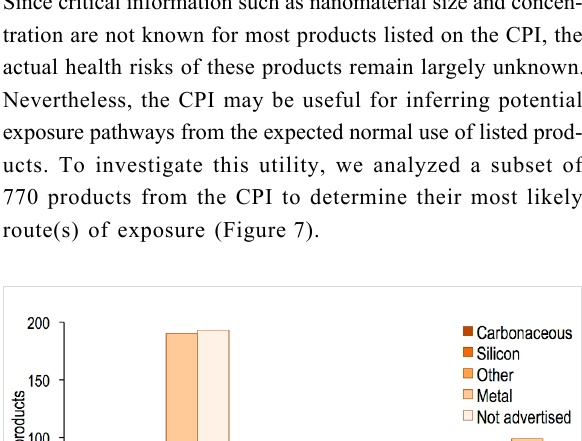
Potential exposure pathways